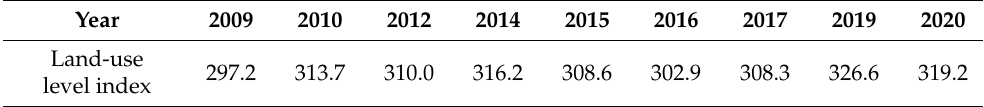
Table 7. The index of land-use intensity in the research